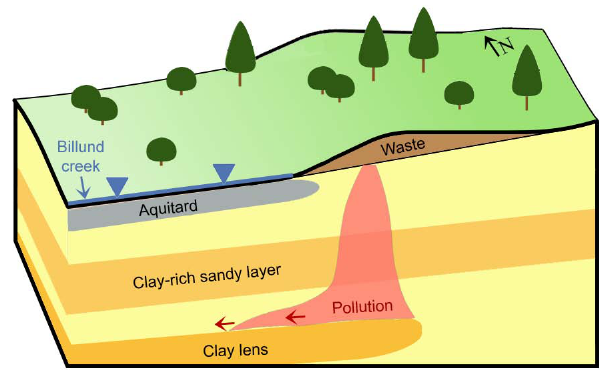
Fig. 12. Qualitative model obtained from geophysical measure- ments for a section crossing the landfill from west to east (not at